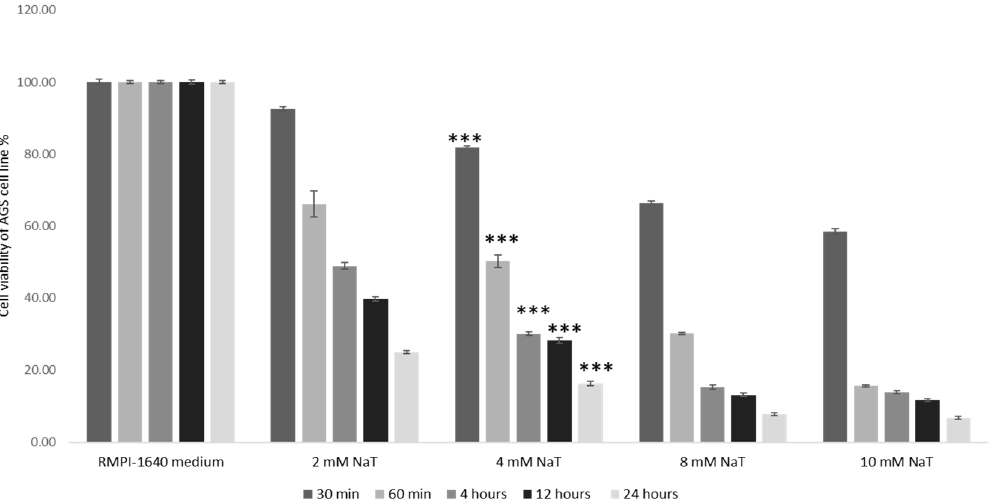
Figure 1. Establishment of the cell culture model of peptic ulcer disease and assessment of the toxic effect of NaT. Determination of cell viability by MTT assay after exposure to varying NaT concentrations and varying time periods in AGS cell line. Two way ANOVA F(125,149) = 1.18 × 10 4 ; p = 3.73 × 10 − 160 post hoc Tukey HSD. Bars assigned with asterisks are statistically significantly different (*** p < 0.001) compared to untreated control. The data shown are representative of at least three independent experiments. Sodium taurocholate (NaT), human gastric cell line (AGS).